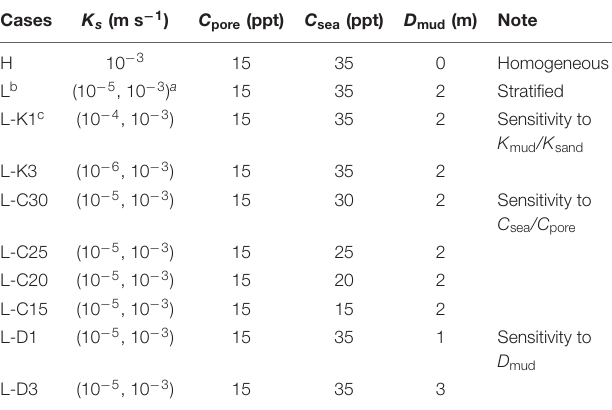
TABLE 2 | Simulated cases with model parameter